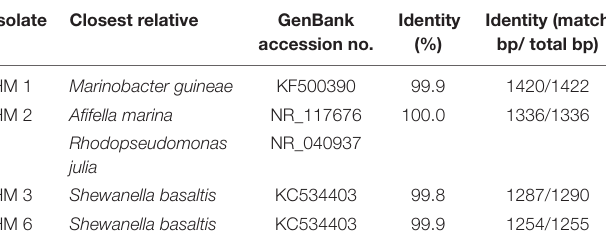
TABLE 2 | 16S ribosomal RNA sequences of